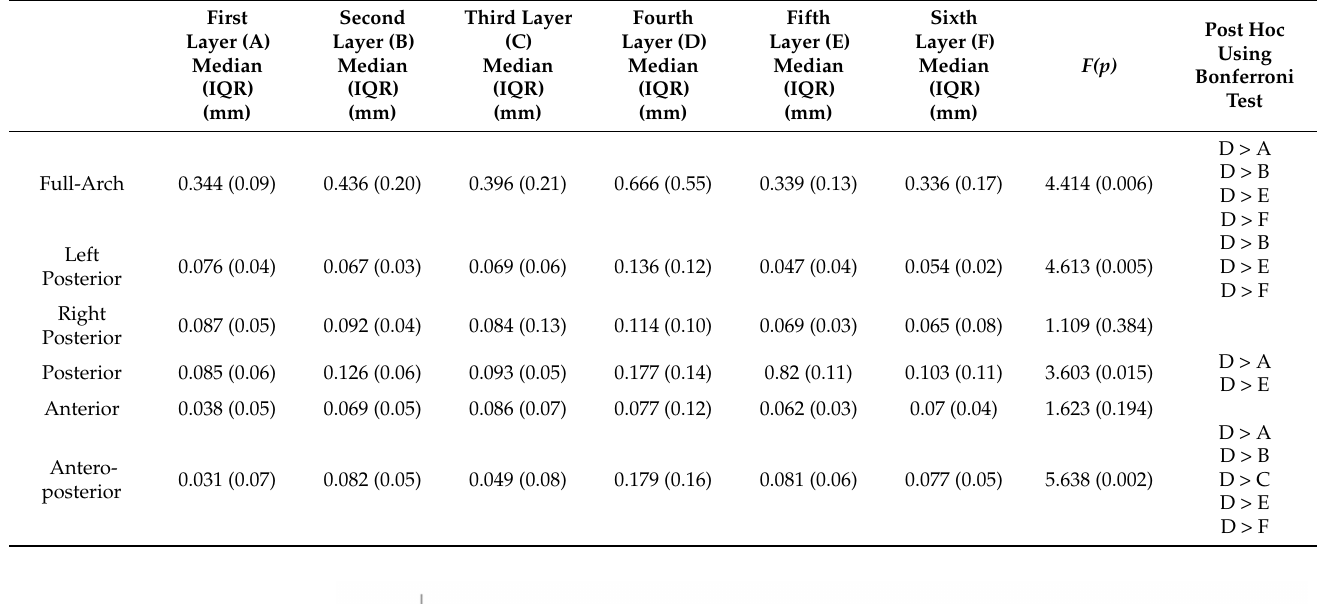
Table 2. Median error (trueness) of the stacked models for full-arch, left posterior, right posterior, posterior, anterior and antero-posterior arch segments. Precision expressed as interquartile error (IQR). Measurements in millimetres.